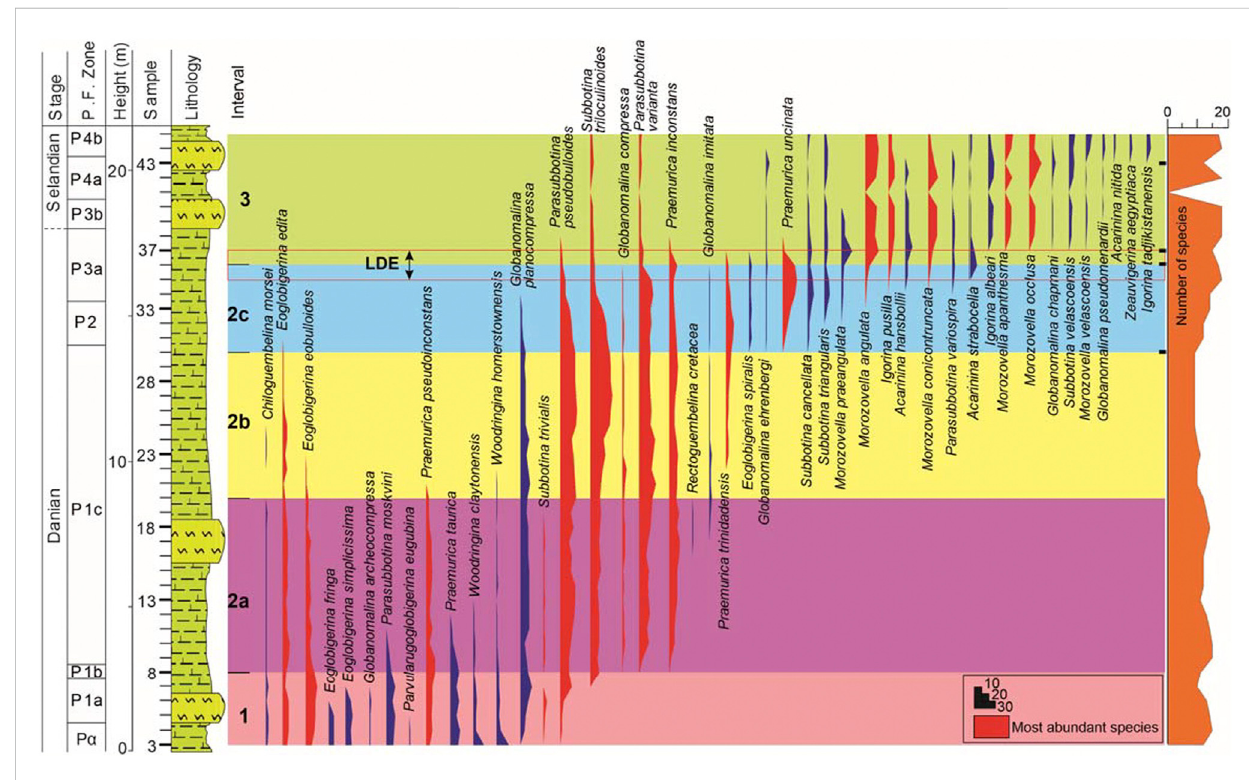
FIGURE 3 Distribution of identi fi ed planktic foraminifera species from the Themed section (El Themed village in East Central Sinai, Egypt). The identi fi ed zones (1 – 3) are based on hierarchical clustering and principal component analysis. Of the 44 identi fi edplanktic foraminiferaspecies, 16 (in red) makeup 84% of the total population. Changes in the number of taxa is also shown on the right (see text for further